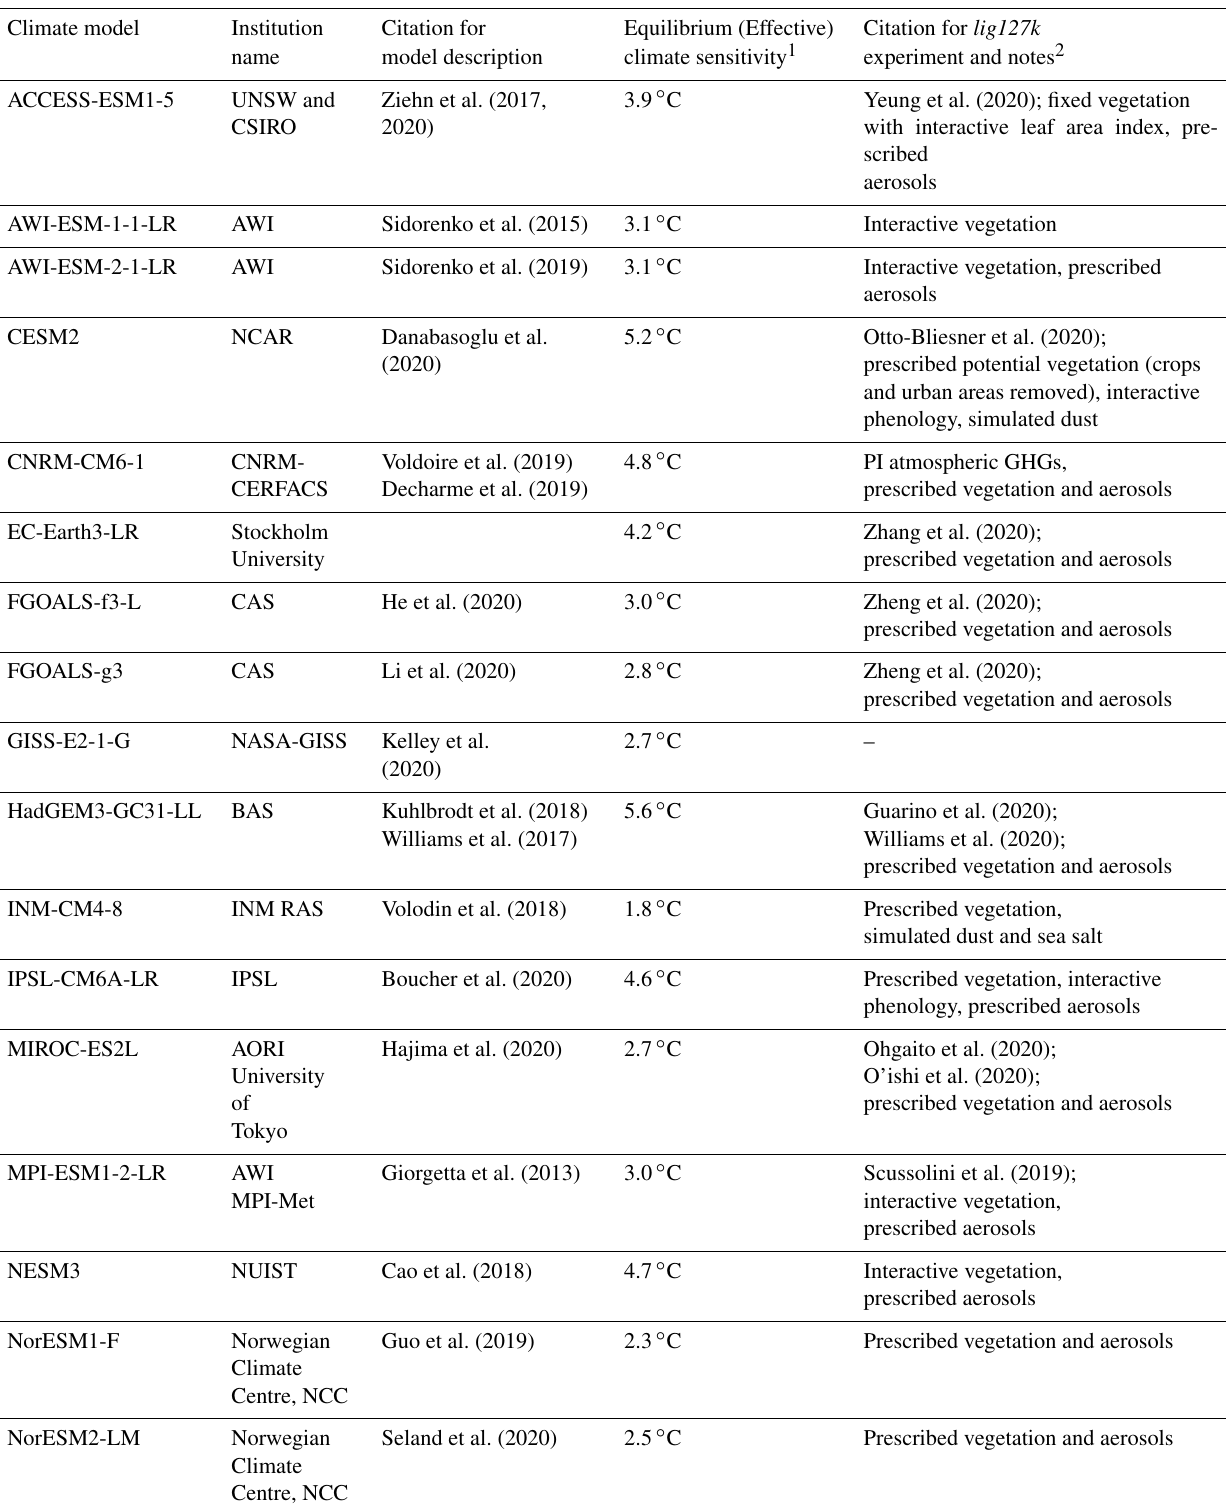
Table 2. Summary of CMIP6–PMIP4 models in this